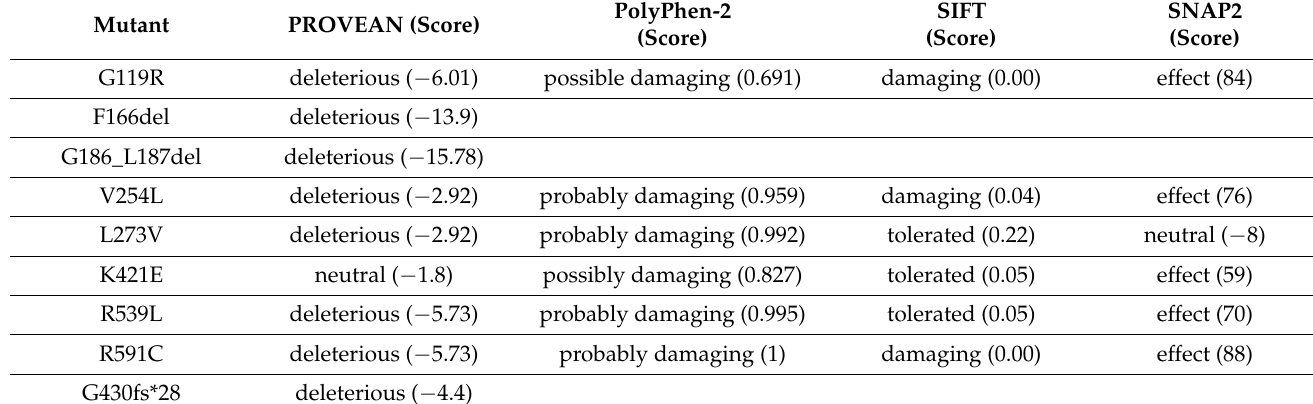
Table 1. Pathogenicity prediction of the different KCNQ1 variants. PROVEAN (Protein Variation Effect Analyzer), PolyPhen-2 (prediction of functional effects of human nsSNPs), SIFT (Sorting Intolerant From Tolerant), and SNAP2 (predicting functional effects of sequence variants) tools were used. Predictions by PROVEAN protein software: score ≤ − 2.5, deleterious; > − 2.5, neutral. The Poly-Phen − 2 score ranges from 0.0 (tolerated) to 1.0 (deleterious). The amino acid substitution prediction by SIFT is damaging when the score is ≤ 0.05, and tolerated if the score is > 0.05. SNAP2 predicts a score that ranges from − 100 (strong neutral prediction) to +100 (strong effect